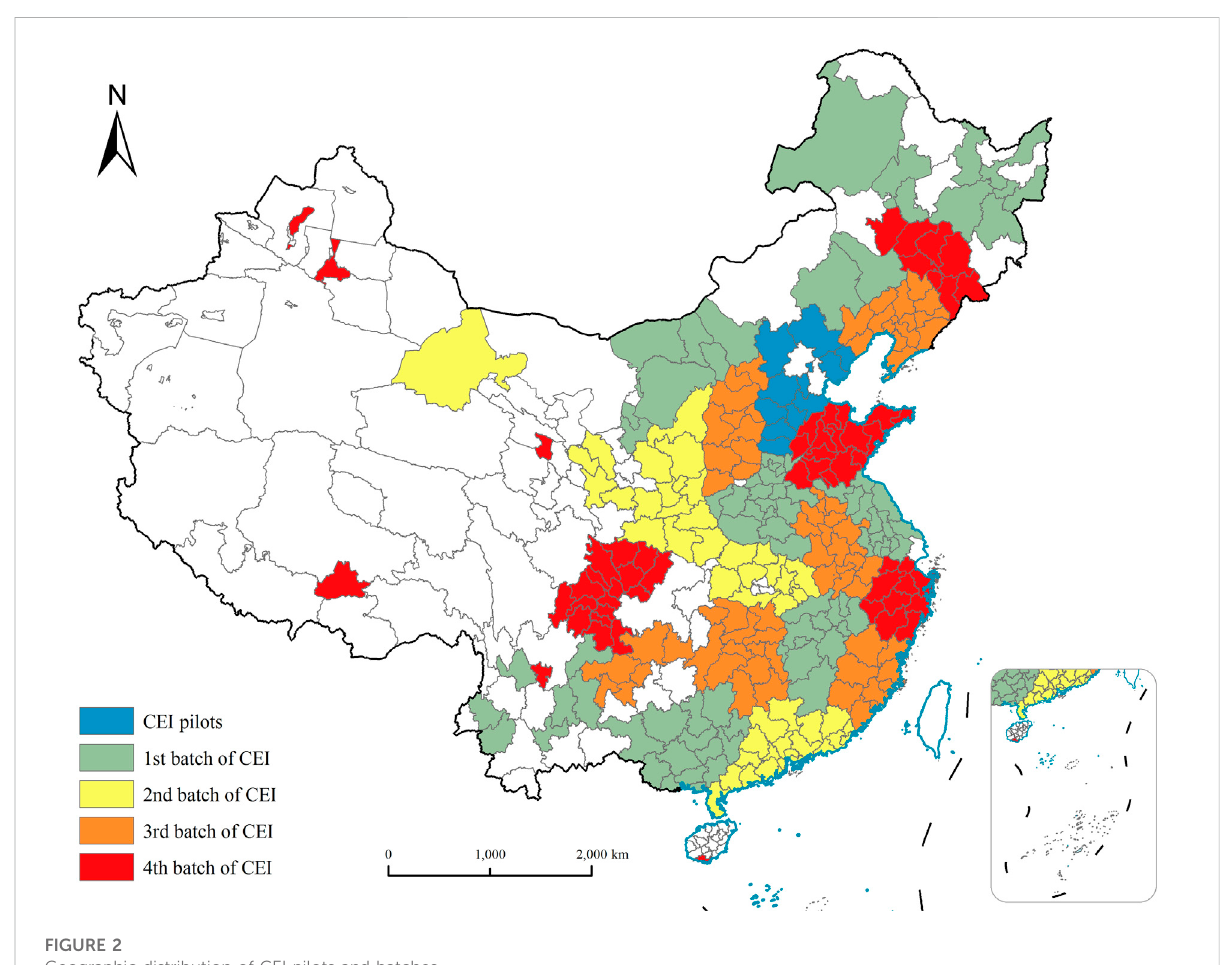
FIGURE 2 Geographic distribution of CEI pilots and batches.